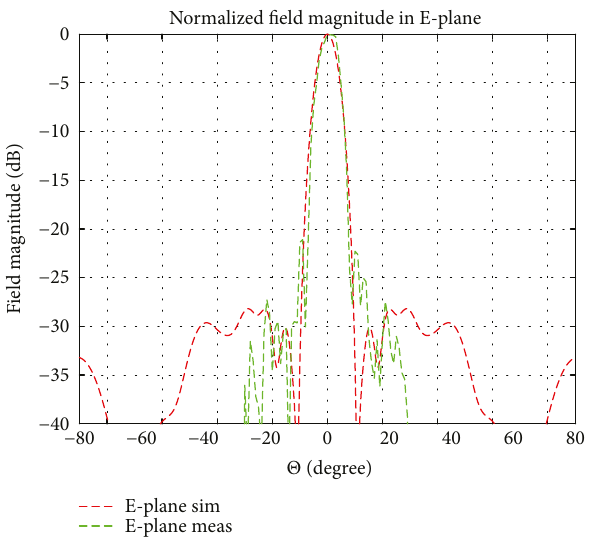
Figure 11: Simulated and measured E-plane radiation patterns from the proposed 3D printed re fl ector antenna at 30GHz.